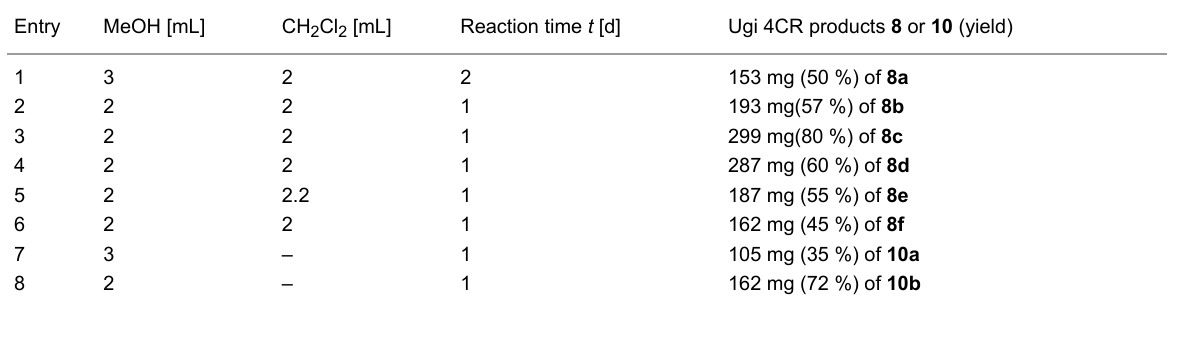
Table 5: Experimental details for the synthesis of the Ugi products 8 and 10